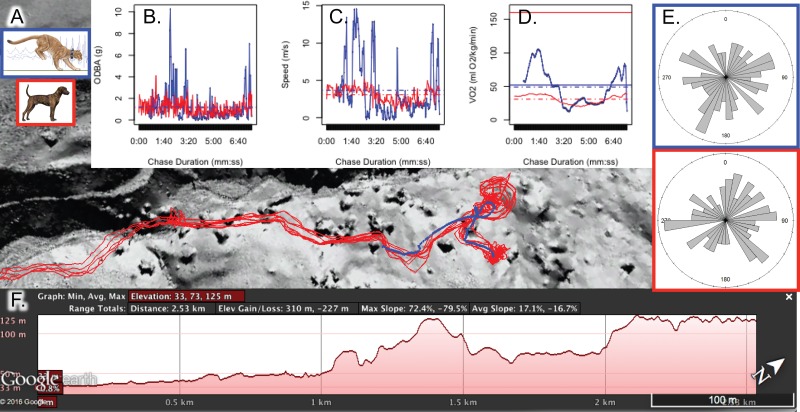
Chase 1 pursuit (red lines = hounds) and escape (blue line = puma) paths (A), including the elevation profile for Brandy, a GPS-accelerometer collar equipped hound.Insets display ODBA (g, B), speed (ms−1, C), and estimated mass-specific metabolic demand (\documentclass[12pt]{minimal}
\usepackage{amsmath}
\usepackage{wasysym}
\usepackage{amsfonts}
\usepackage{amssymb}
\usepackage{amsbsy}
\usepackage{upgreek}
\usepackage{mathrsfs}
\setlength{\oddsidemargin}{-69pt}
\begin{document}
}{}$\dot {\mathrm{V }}{\mathrm{O}}_{2}$\end{document}V ˙O2 in ml O2kg−1min−1, D) For (B), (C), and (D), mean values are presented as dashed horizontal lines, and solid horizontal lines in (D) depict \documentclass[12pt]{minimal}
\usepackage{amsmath}
\usepackage{wasysym}
\usepackage{amsfonts}
\usepackage{amssymb}
\usepackage{amsbsy}
\usepackage{upgreek}
\usepackage{mathrsfs}
\setlength{\oddsidemargin}{-69pt}
\begin{document}
}{}$\dot {\mathrm{V }}{\mathrm{O}}_{2\mathrm{MAX}}$\end{document}V ˙O2MAX for each species. Tortuosity plots (proportion of turns in each compass direction, (E) and the elevation profile for the accelerometer-GPS-equipped hound (F) are also presented. Map data© 2016 Google.